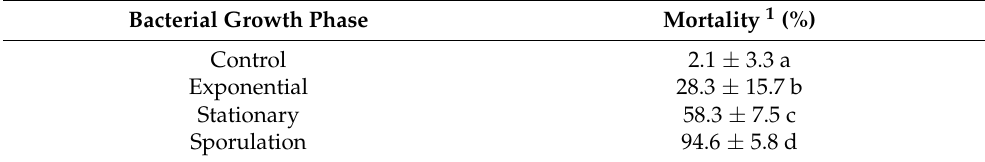
Table 1. Mortality (mean ± sd) of Panagrellus redivivus after exposure for 48 h to Brevibacillus laterosporus culture supernatant collected at different bacterial growth stages.